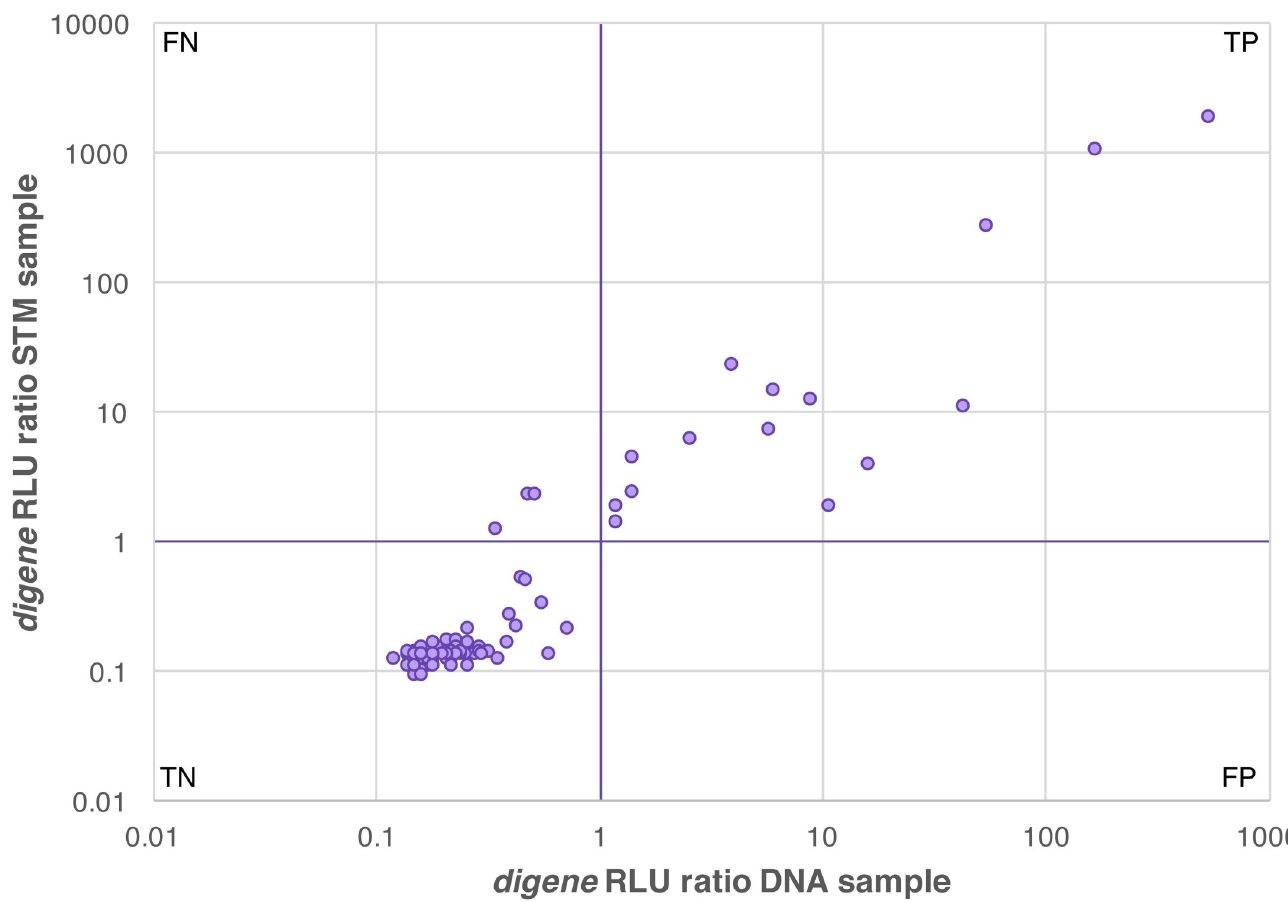
Fig 6. digene HC2 High-Risk HPV assay performance on a set of 87 paired, self-collected cervicovaginal samples. Samples were tested directly from STM tubes or from a paired sample after DNA extraction. The purple lines show the cutoff of the digene assay (RLU ratio = 1). Three STM specimens were positive for hrHPV with an average RLU ratio of < 2 (low positive), but below RLU ratio = 1 for their corresponding extracted DNA specimen. The results for all other 84 specimens were concordant. TN, true negative; TP, true positive; FN, false negative; FP, false positive.